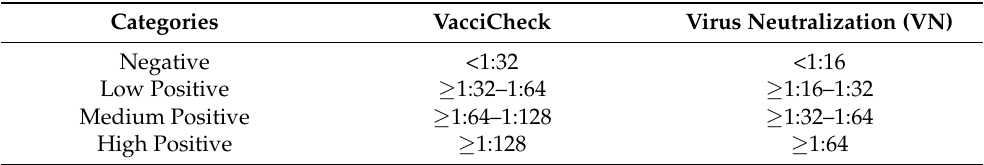
Table 1. Categorization based on antibody titer for VacciCheck (positivity threshold ≥ 1:32) and virus neutralization (VN) (positivity threshold ≥